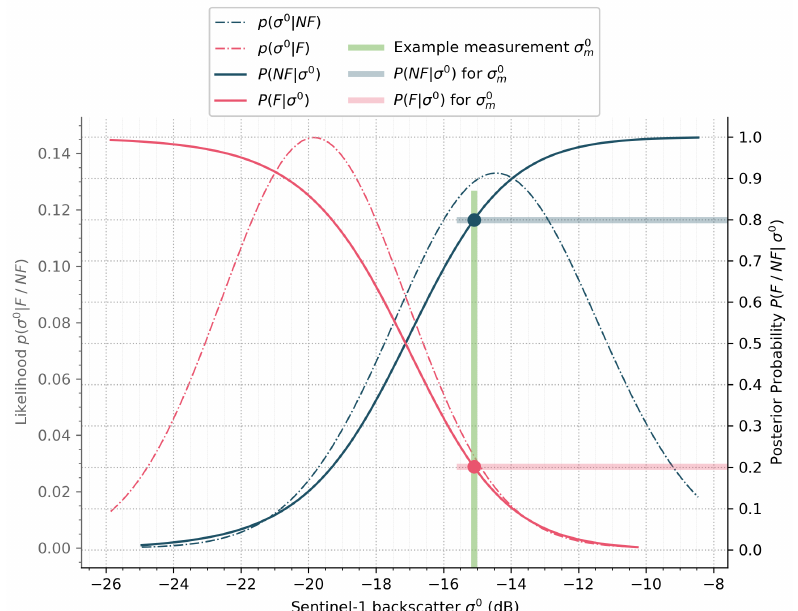
Figure 3. Bayesian flood mapping procedure over one pixel for an exemplary backscat- (cid:0) (cid:1) PDF; p ( σ 0 | F / NF ter measurement, including the probability density functions and pos- (cid:0) (cid:1) P ( F / NF | σ 0 ) terior probabilities of the two classes flooded ( F ) and non-flooded ( NF ). This example illustrates a challenging situation with relatively close local parameters (cid:0) (cid:1) p ( σ 0 | F ) : µ w = − 19.83, s w = 2.73 | p ( σ 0 | NF ) : µ l = − 14.43, s l = 2.99 . The marked backscatter observation at -15.1dB has a probability of 0.8 to belong to the class non-flood ( NF ), with an uncer- tainty of